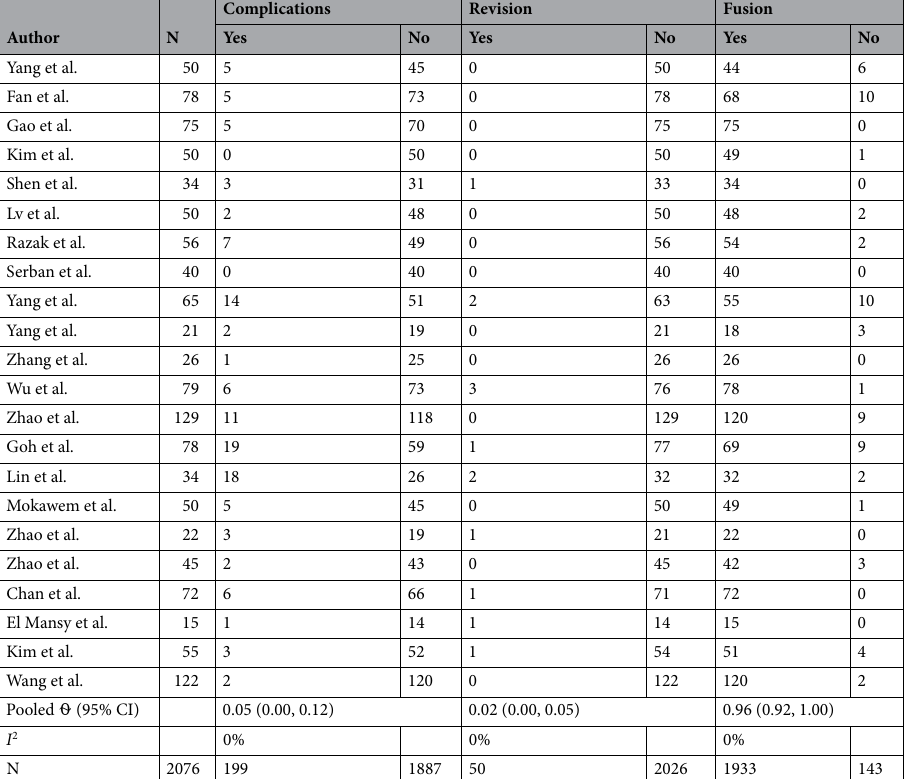
Table 3. Estimation of the pooled means and prevalences for surgical mean time, blood loss, hospital stay, complications, revision and fusion in MI-TLIF studies.